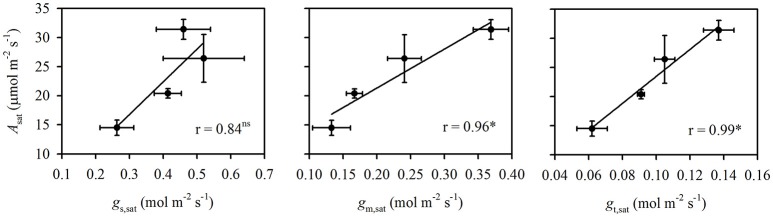
The correlations of Asat vs. gs,sat, gm,sat, and gt,sat. The data are the means ± SD of three replications. *Represents significance at the P < 0.05 level, while ns represents no significance at the P < 0.05 level.